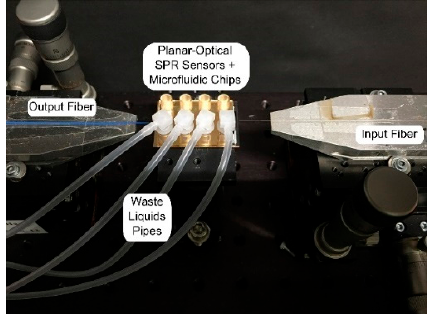
Figure 2. Picture of the experimental setup showing the planar-optical waveguide SPR sensor including the microfluidic chip (middle) as well as the two optical glass fibers for light coupling into (right) and out (left) of the structure.